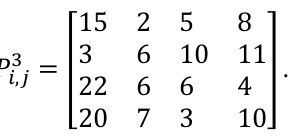
Table 6. Potential non-dominated points for the second objective function 𝑍